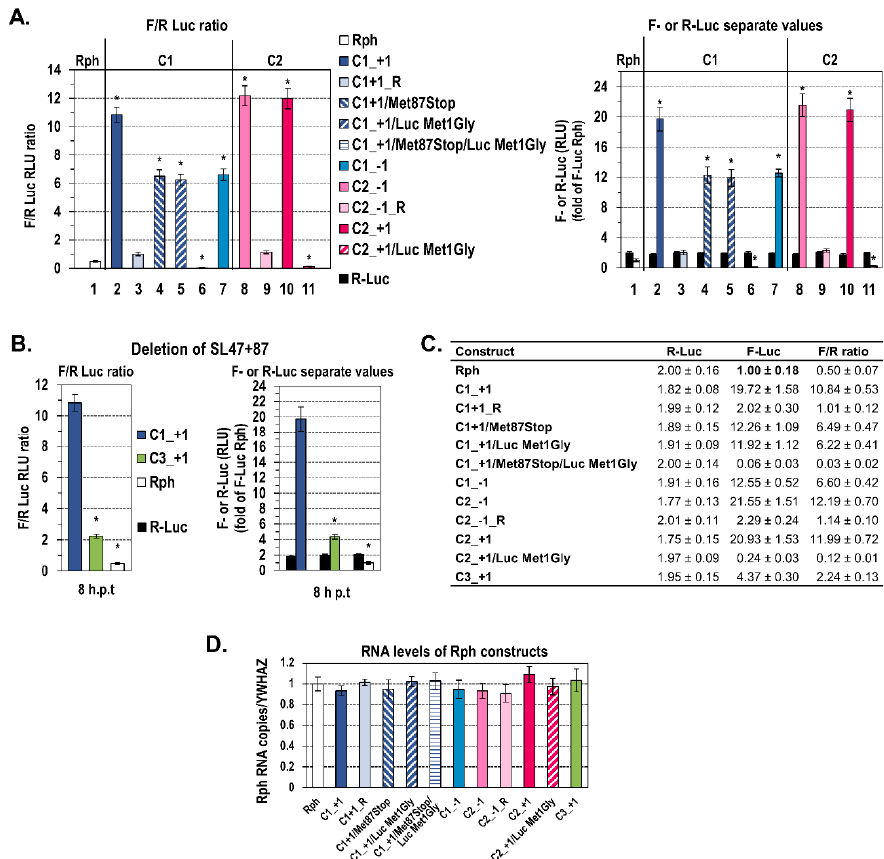
Figure 2. Evidence for a novel cis-acting element within the core coding sequence with capacity for internal translation initiation. ( A ) The F-Luc to R-Luc values ratio (F / R) or separate values of F-Luc and R-Luc activities detected in Huh7 cells after transfection with in vitro transcribed, capped, and polyA-tailed Rph-derived RNA containing either C1 or C2 core nucleotide sequence, in 5 (cid:48) -3 (cid:48) or reverse (R) orientation, and the F-Luc gene fused in the core + 1 or core − 1 frame, in the absence or presence of the mutation Met87stop and / or substitution Luc Met1Gly. Cells were cultured for 8 h post-transfection initiation (h p.t). Values are means ± SD of four independent experiments in triplicate, expressed as relative light unit (RLU) ratio ( left ) or as separate F-Luc and R-Luc RLUs ( right ). F-Luc and R-Luc values obtained from cells transfected with the di ff erent constructs were expressed relative to the F-Luc value of the negative control empty vector Rph, which was set to one, and their ratios were calculated. Total protein amount was used for normalization. * p < 0.001 cells transfected with C1, C2 constructs vs. Rph empty vector, 5 (cid:48) -3 (cid:48) constructs vs. R ones, mutated constructs vs. wild-type ones (Student’s t test). ( B ) Ratio F / R ( left ) or separate values ( right ) of F-Luc and R-Luc activities derived from Huh7 cells after transfection with in vitro transcribed, capped, and polyA-tailed C3_ + 1 Rph RNA as compared to the C1_ + 1 Rph construct. Cells were lysed 8 h p.t. Mean values were obtained from four independent experiments in triplicate and expressed as RLU ratio ( left ) or as separate F-Luc and R-Luc RLUs ( right ). F-Luc and R-Luc values were expressed relative to the F-Luc value derived from cells transfected with the negative control Rph, which was set to one, and their ratios were calculated. * p < 0.001, vs. C1_ + 1-transfected cells (Student’s t test). ( C ) Table presenting the data of panel ( A ) and panel ( B ) graphs. ( D ) RNA levels quantified 8 h p.t. of Huh7 cells with in vitro transcribed RNAs from the di ff erent Rph constructs, by RT-qPCR analysis of F-Luc gene. The expression of YWHAZ cellular gene was used for normalization. Three independent experiments were